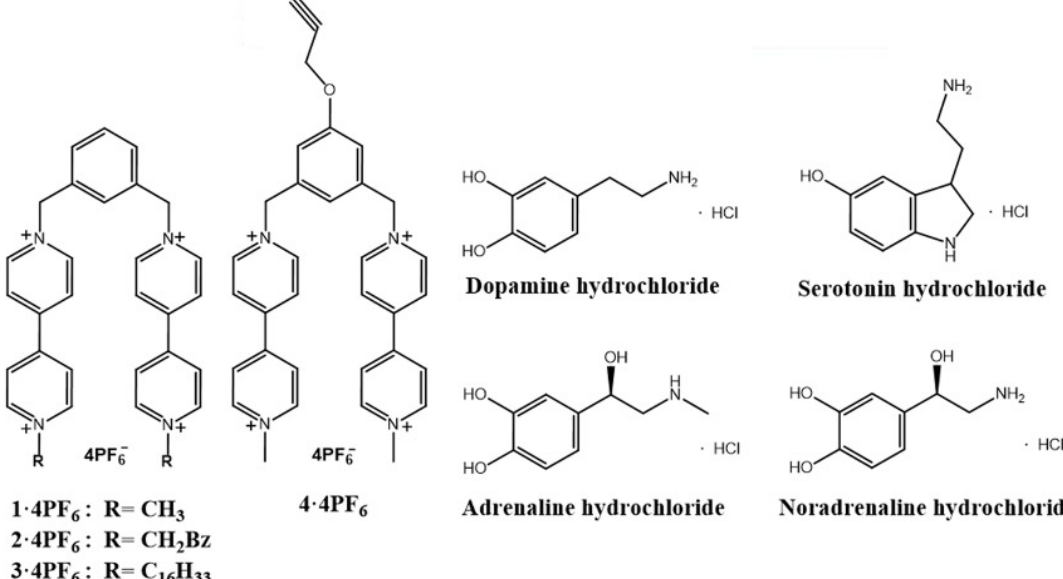
Figure 1. Bipyridinium salts 1 · 4PF 6 – 4 · 4PF 6 and neurotransmitters: dopamine hydrochloride ( D ), serotonin hydrochloride ( S ), adrenaline hydrochloride ( A ) and noradrenaline hydrochloride ( NA ).